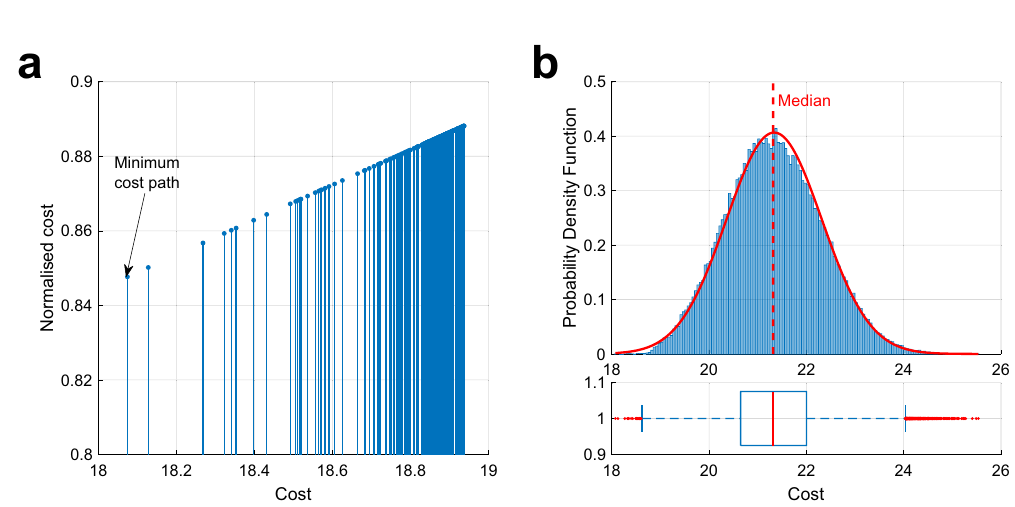
Figure 6. The characteristics used in simulation. The piecewise-linear in (8) ( a ) and the polynomial ( v k / V k ) ( b ). There is no essential difference in the final results of the simulations. For large enough values of r , the current follows the shortest path.